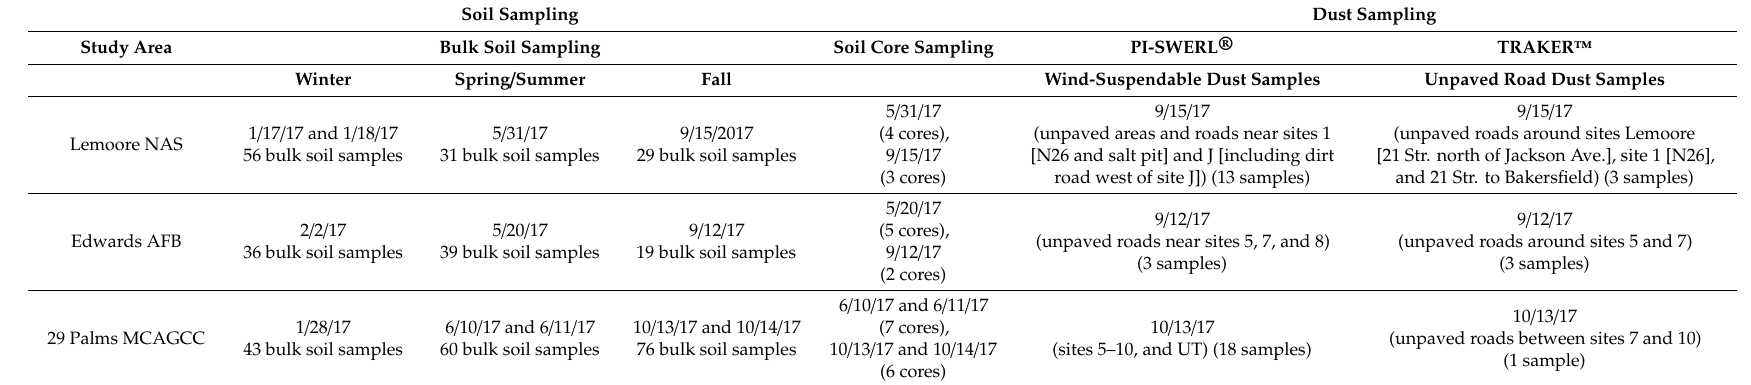
Table 1. Overview of numbers of bulk soil (5–7 cm), soil core (0–30 cm at intervals), and dust samples collected around three U.S. military bases at di ff erent times of the